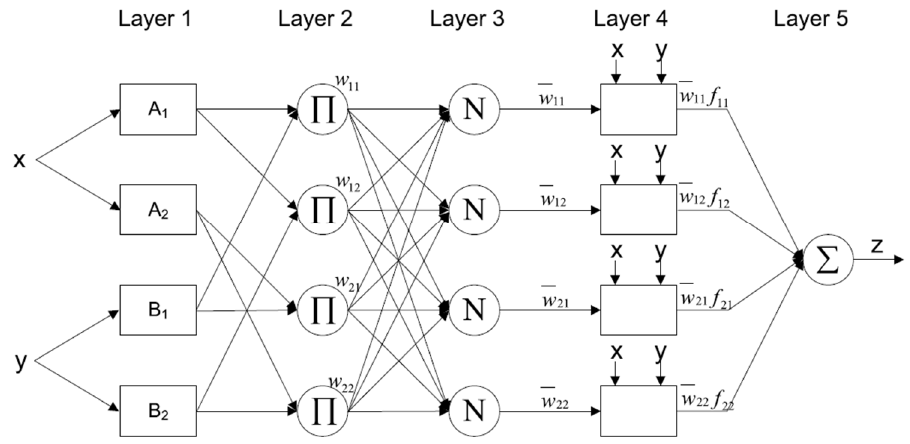
Figure 3. The ordinary architecture of ANFIS.